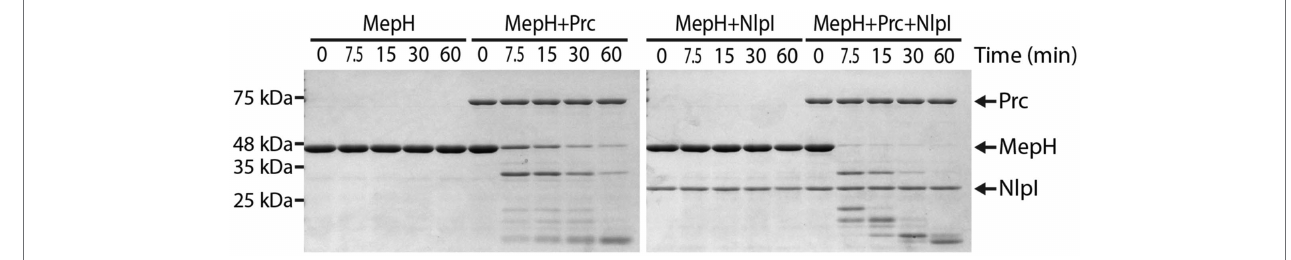
FIGURE 7 | Prc degrades MepH and this degradation is enhanced by NlpI. Time course experiment for MepH degradation in the presence or absence of Prc and NlpI. Four different reactions that contained the indicated proteins were prepared in PBS buffer and incubated at 37 ° C. Note that His6-SUMO-tagged MepH (H-SUMO-MepH) was used instead of MepH because untagged MepH was not soluble. H-SUMO-MepH is labeled as MepH in this figure for convenience. The concentrations of each protein added to the reactions were 5 μ M (MepH), 1 μ M (Prc), and 2 μ M (NlpI). Aliquots were taken from each reaction at the indicated time points, mixed with Laemmli sample buffer, and boiled. Samples were separated on 12% SDS-PAGE gels and the gels were stained with Coomassie brilliant blue. Positions of molecular weight markers are indicated on the left and positions of the proteins used in the assay are indicated with arrows on the